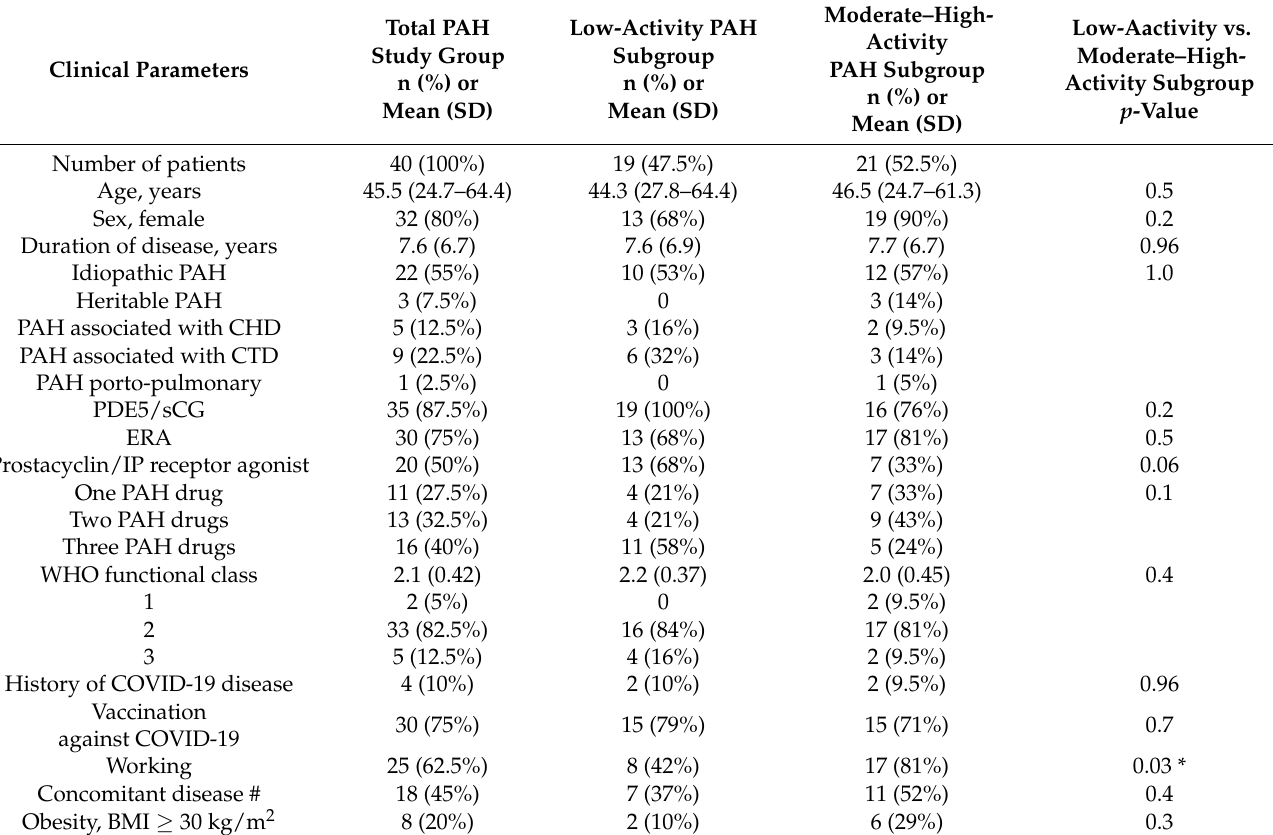
Table 1. Clinical characteristics of the study